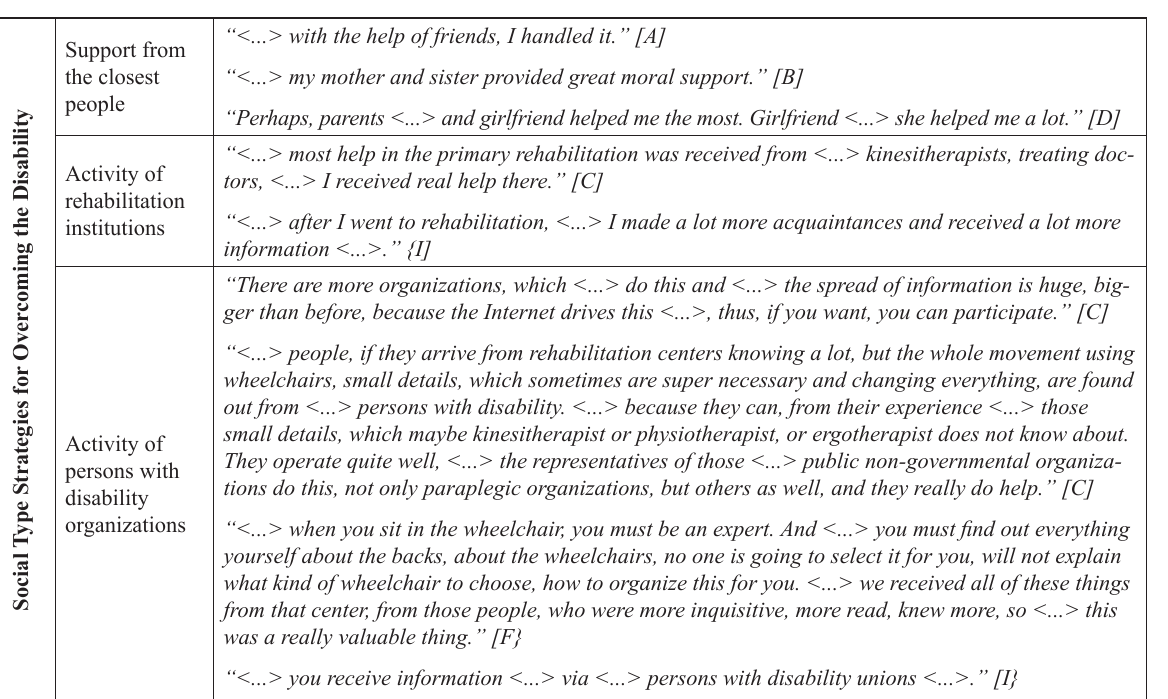
Table 2. The Acceptance of the Fact of Disability and Strategies for Overcoming